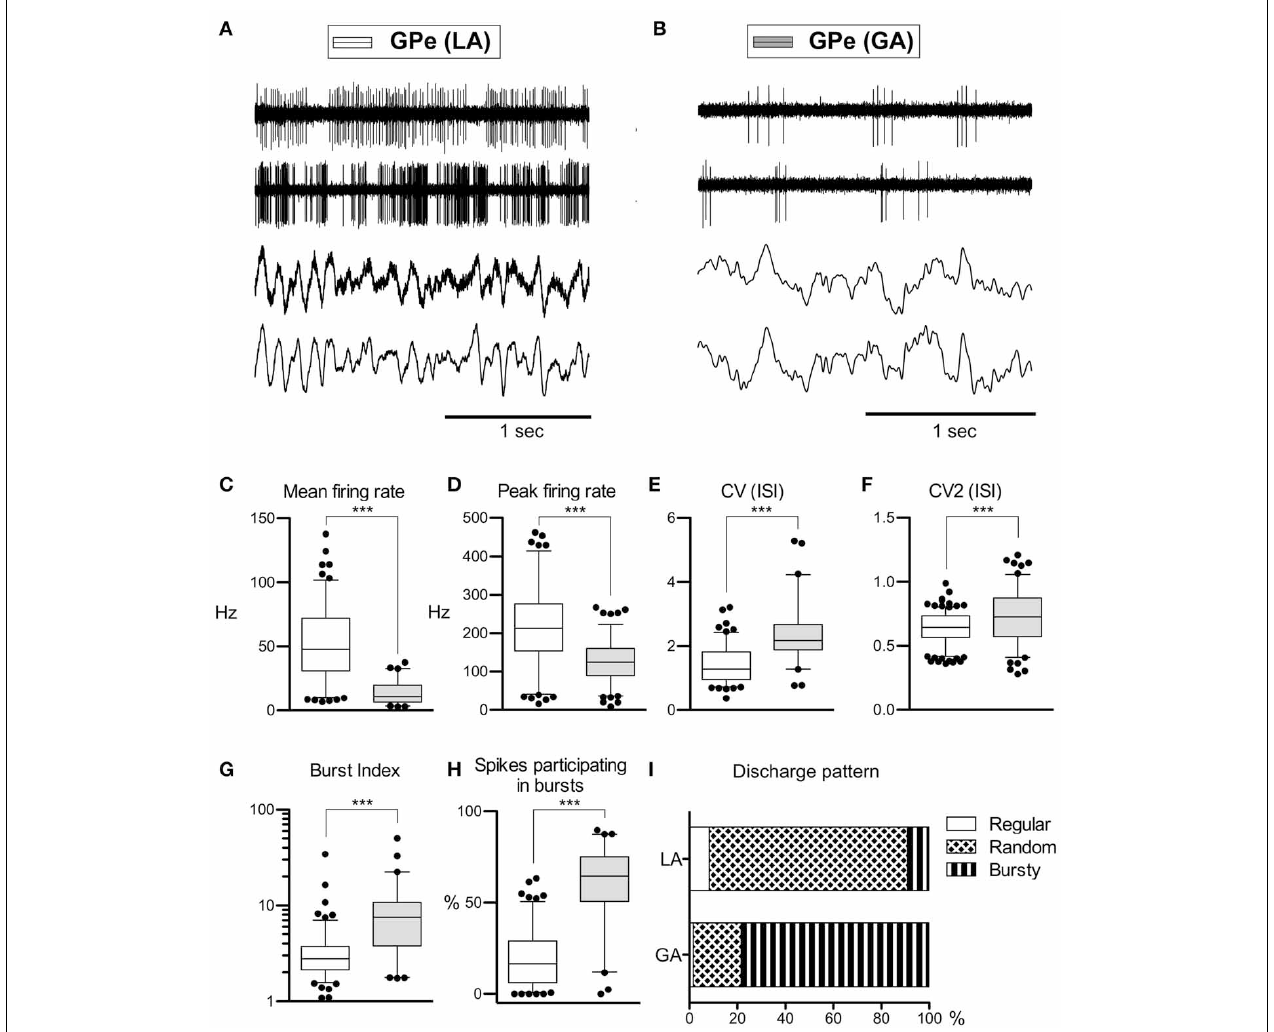
FIGURE 1 | Comparison of discharge rates and patterns of GPe neurons in CD patients under LA and GA. (A) Raw data showing spontaneous neuronal discharges and LFPs recorded simultaneously from two different micro- and macroelectrodes in the GPe of a CD patient (surgery under LA, case 7). (B) Raw spike and LFP data segment recorded from the GPe of a patient operated under GA (case 13). (C–H) Box and whisker plots of various discharge parameters. Abbreviations: Peak firing rate, 95th percentile rate; CV (ISI), coefficient of variation of the interspike intervals; CV2 (ISI), local coefficient of variation of the interspike intervals as determined by the method of Holt et al.